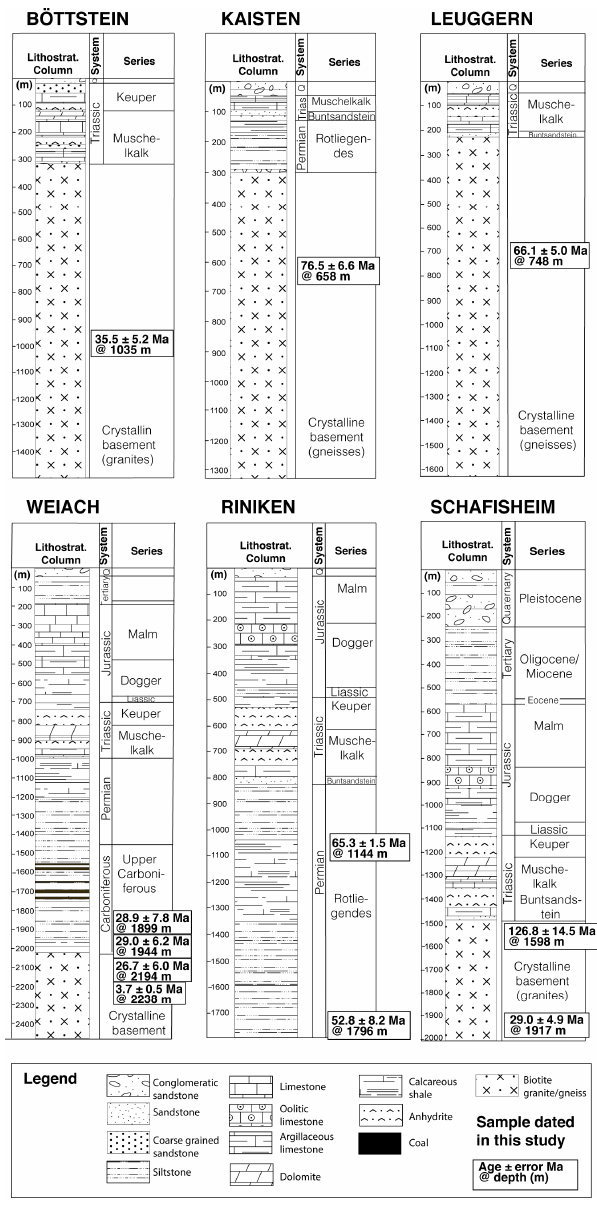
Figure 4. Well lithology and apatite fission track LA–ICP–MS age results. Columns are simplified from [6–11].